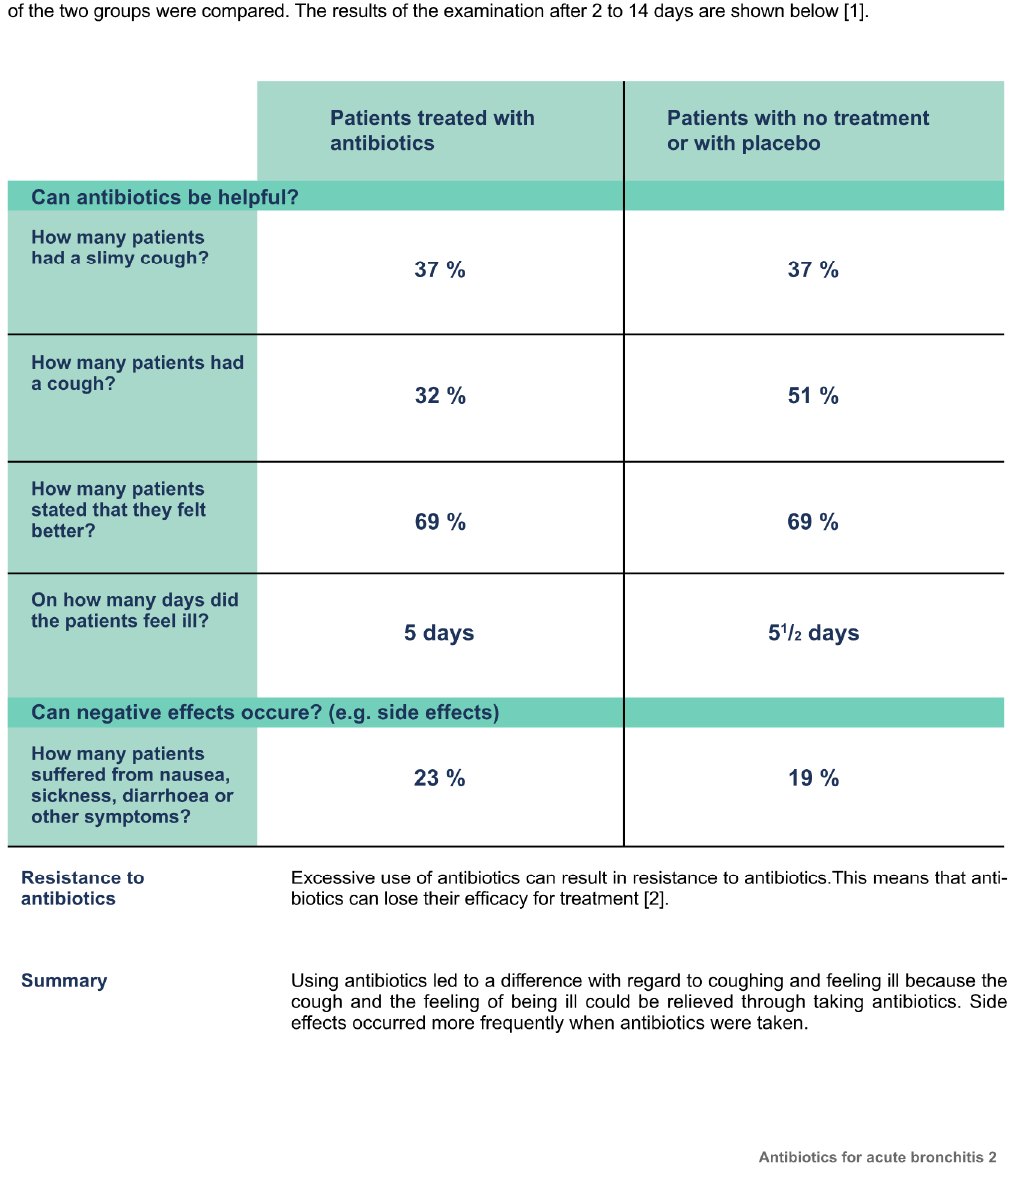
Figure 2. The fact box that presented treatment effects as percentages.